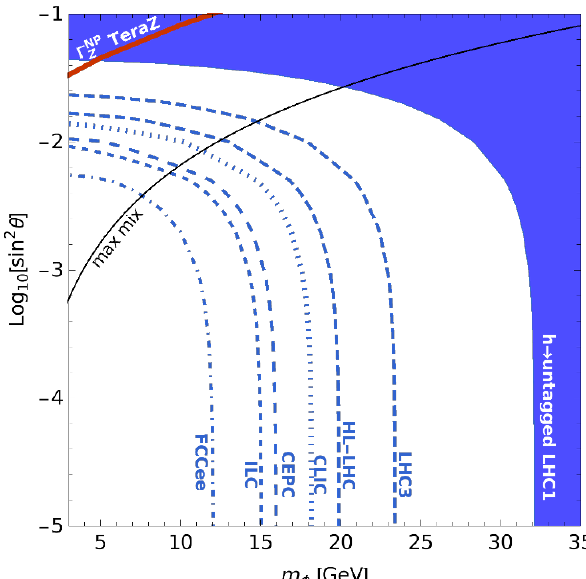
Figure 2 . Precision bounds on sin 2 (cid:18) and m (cid:30) : upper limit on the untagged branching ratio of the Higgs boson, here h ! (cid:30)(cid:30) (blue), obtained via the precision of Higgs couplings. Current (solid, blue area) and projected (blue, dashed) exclusion from the (HL-)LHC, CLIC at with 500 fb (cid:0) 1 , CEPC at 250 GeV with 5 ab (cid:0) 1 , ILC with 250 GeV with 2 ab (cid:0) 1 and FCCee at 240 GeV with 10 ab (cid:0) 1 . The energies, luminosities and upper bounds on BR( h ! NP) of the collider benchmarks are summarized in table 1. The contours represent the 95% CL, except for LHC3 and HL-LHC which are at 68% CL. Projection of the constraint on the NP contribution (cid:0)( Z ! (cid:30)f (cid:22) f ) to the total Z -width, assuming the experimental precision of the FCCee running at the Z -pole with 10 12 Z and an improved theory uncertainty (red). The black line shows the upper bound on the mixing according to eq.